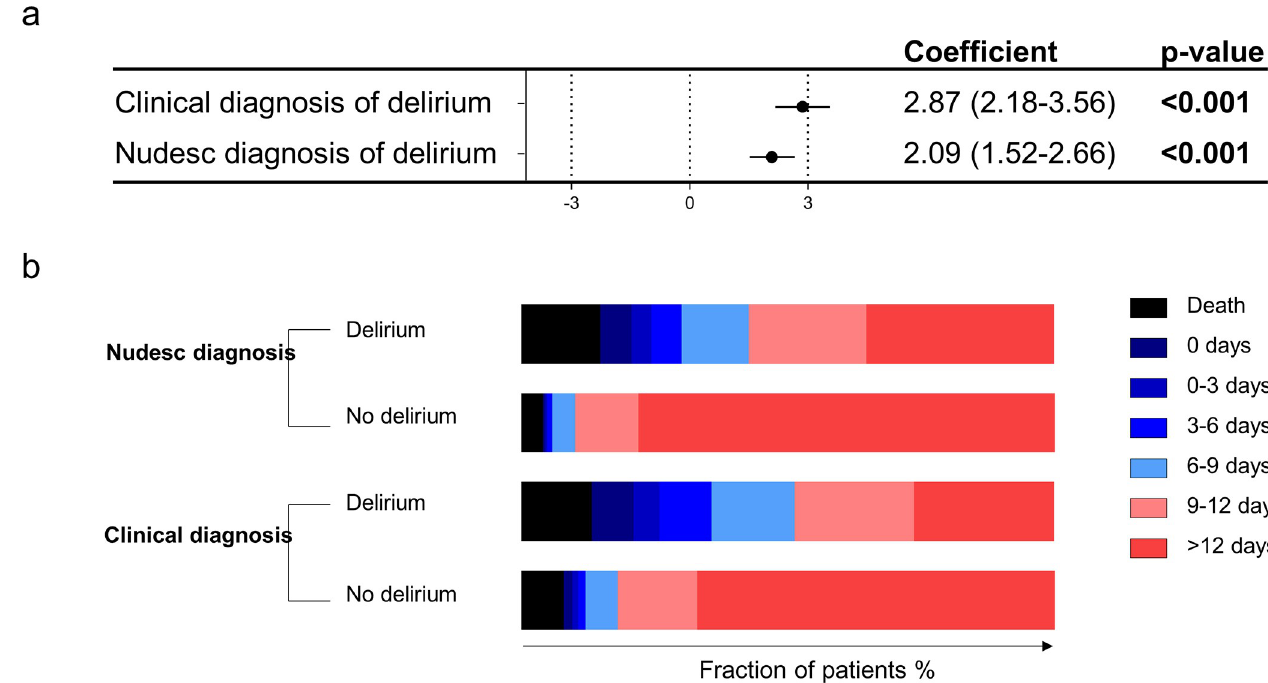
Fig 2. Duration of stay on the intensive care unit (ICU). Multivariable linear regression analysis showing regression coefficients for ICU stay (days) in all surviving patients adjusted for age, mechanical ventilation, severe shock, acute kidney and SAPS 2 � 50 (a). ICU free days 15 days after ICU admission (b).